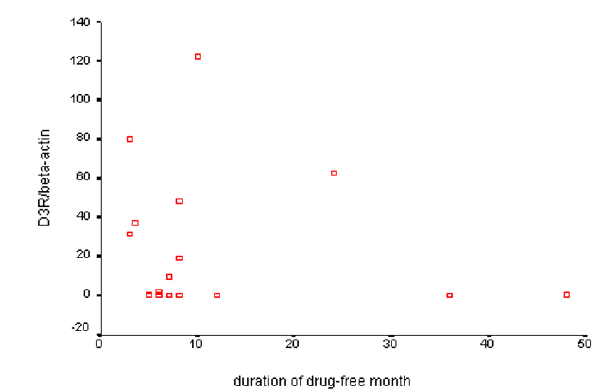
Figure 6 Relationship between D3R/ β A and drug-free duration in drug-free patients. To analyze the cause of high dopamine receptor in drug-free patients, the relationship between D3R/ β A and drug-free duration is shown. Though negative correlation may be suggested, it was not statistically significant.